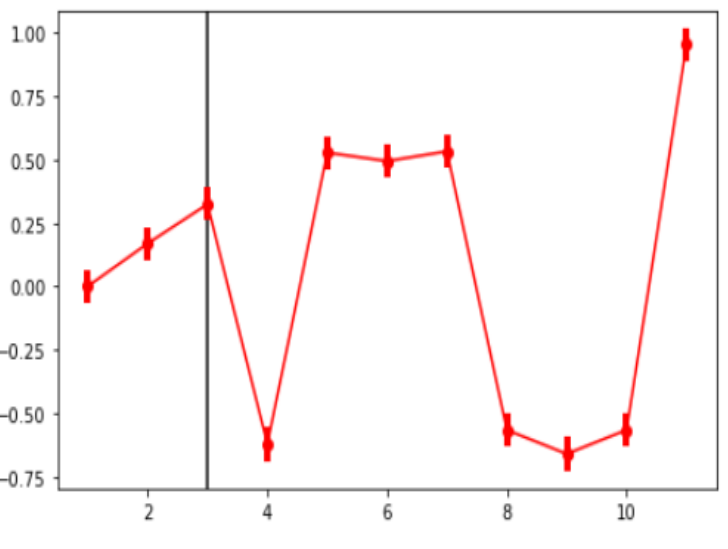
Figure 9. An example of gap statistic